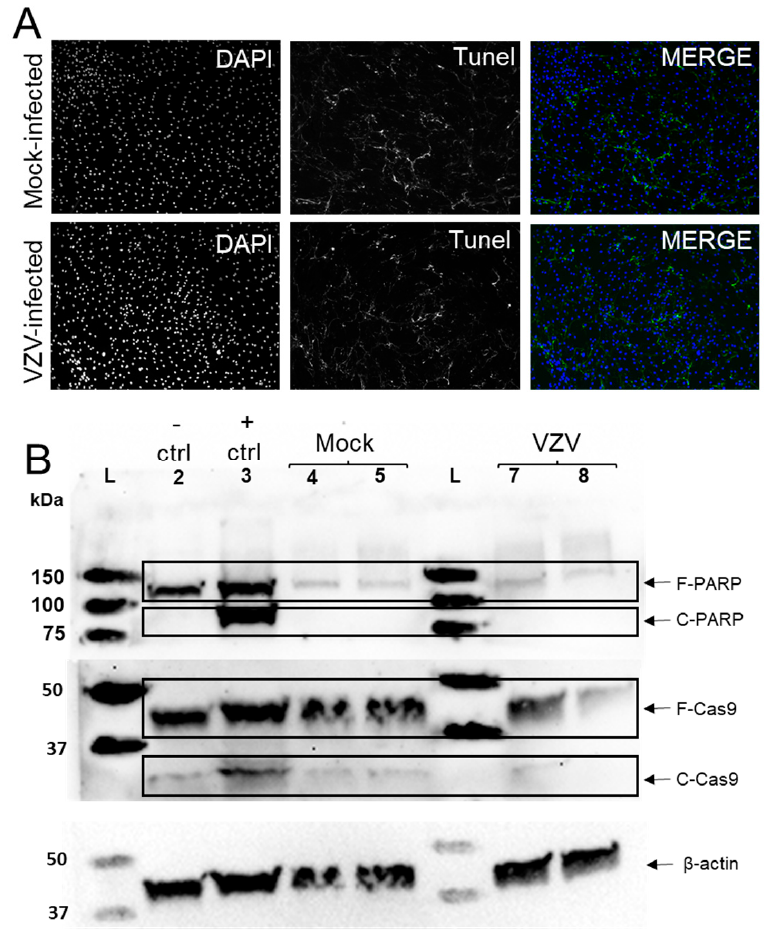
Figure 2. VZV infection of quiescent human adrenal cortical cells (qHAdCCs) does not cause cell death. ( A ) At 3 days post-infection (DPI), a TUNEL assay kit with BrdU-Red that detects DNA fragmentation during cell death (apoptosis, necroptosis, and pyroptosis) did not show increased staining in VZV- compared to mock-infected qHAdCCs. ( B ) Western blot analysis was completed to assess for hallmarks of apoptosis (cleaved caspase 9 [Cas-9] and cleaved poly [ADP-ribos] polymerase [PARP]). The apoptosis negative control was uninfected human lung fibroblasts (HLFs, lane 2) and the positive control was HLFs treated with 1 µ M saurosporine to induce apoptosis (lane 3). The negative and positive apoptosis controls, mock-infected qHAdCCs (lanes 4 and 5, duplicates), and VZV-infected qHAdCCs (lanes 7 and 8, duplicates) all contained bands corresponding to full-length PARP (F-PARP, 116 kDa); cleaved PARP (C-PARP, 89 kDa) was only present in the positive control; C-PARP was absent in the negative control and mock- and VZV-infected cells. The apoptosis controls (negative and positive), mock-infected qHAdCCs, and VZV-infected qHAdCCs all contained bands corresponding to full-length caspase 9 (F-Cas9, 47 kDa). Cleaved caspase 9 (C-Cas9, 37 kDa) was seen in the positive control and absent or barely detectable in the negative control and mock- and VZV-infected cells. Blots were stripped and probed for β -actin as a loading control. L = Molecular weight ladder. Image magnification A = 10 ×